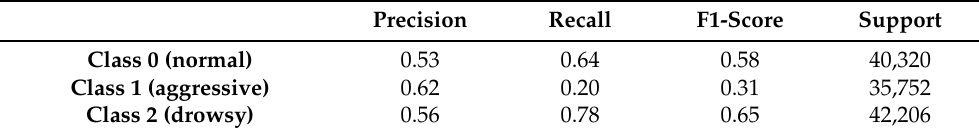
Table 3. Multi-class evaluation metrics with random forest classifier for lane detection.